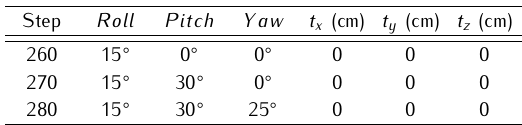
Table 5. Translational motion given to the Phantom during scanning of projections at 260°, 270°, and 280°.